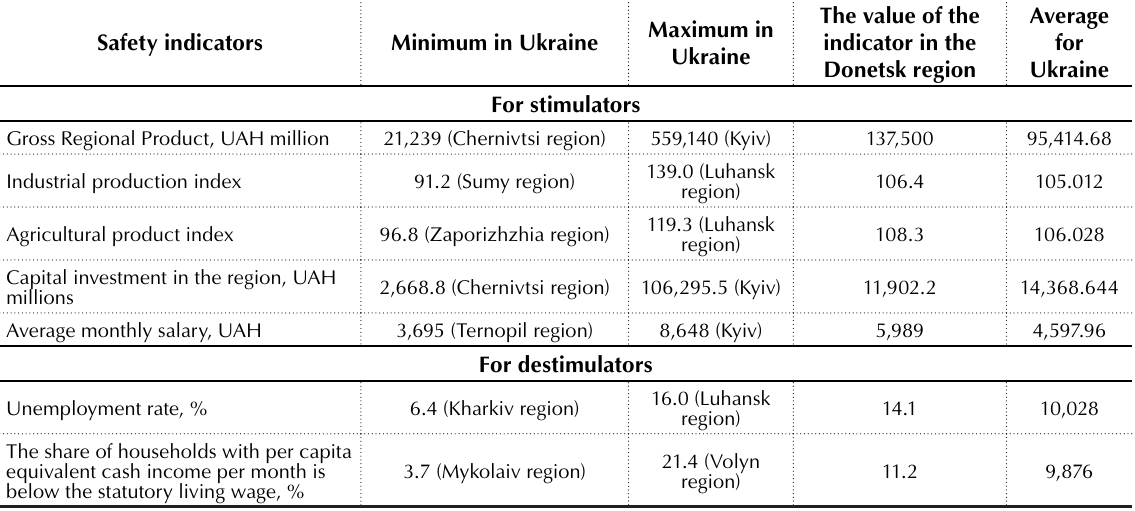
Table 4. Value of indicators of financial and economic security of Donetsk region in 2016 Safety indicators Minimum in